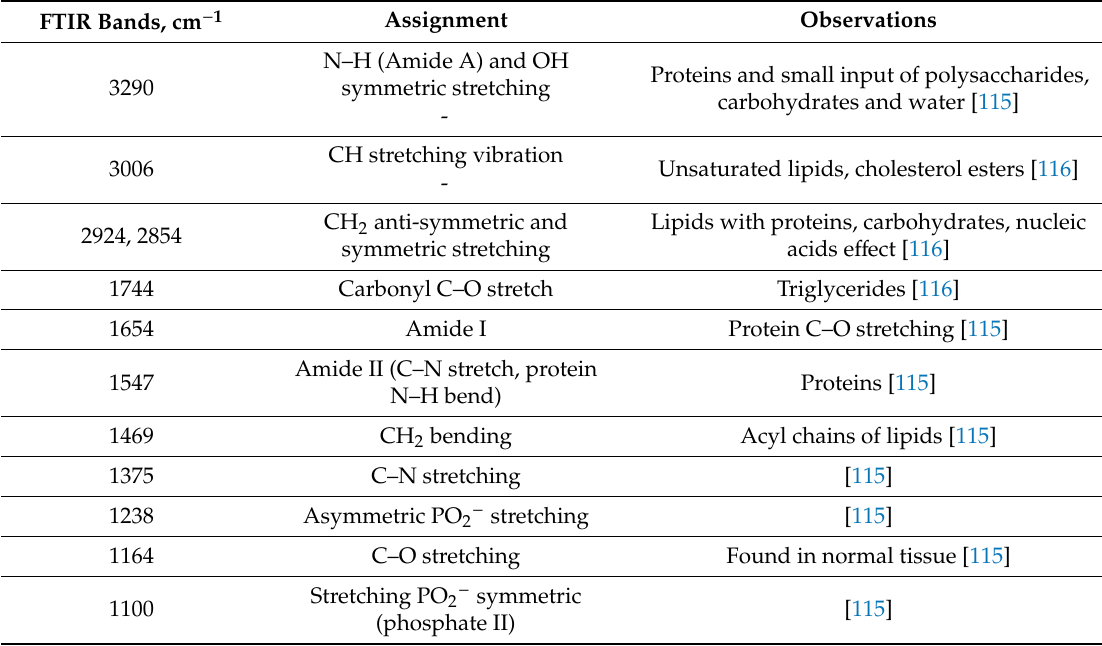
Table 3. Typical FTIR band assignments of an adipose